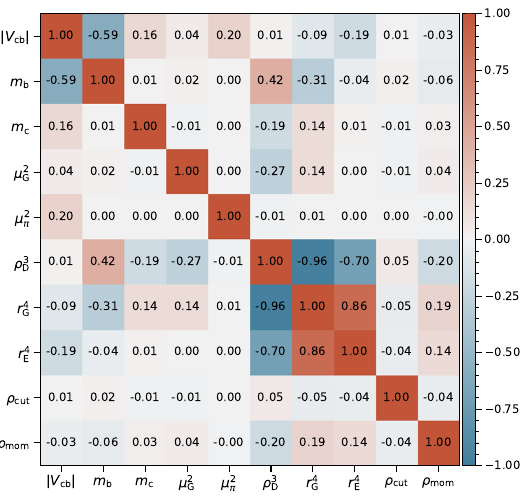
Figure 9 . Correlation matrix for | V cb | , the HQE parameters, and the correlation parameters ρ cut and ρ mom